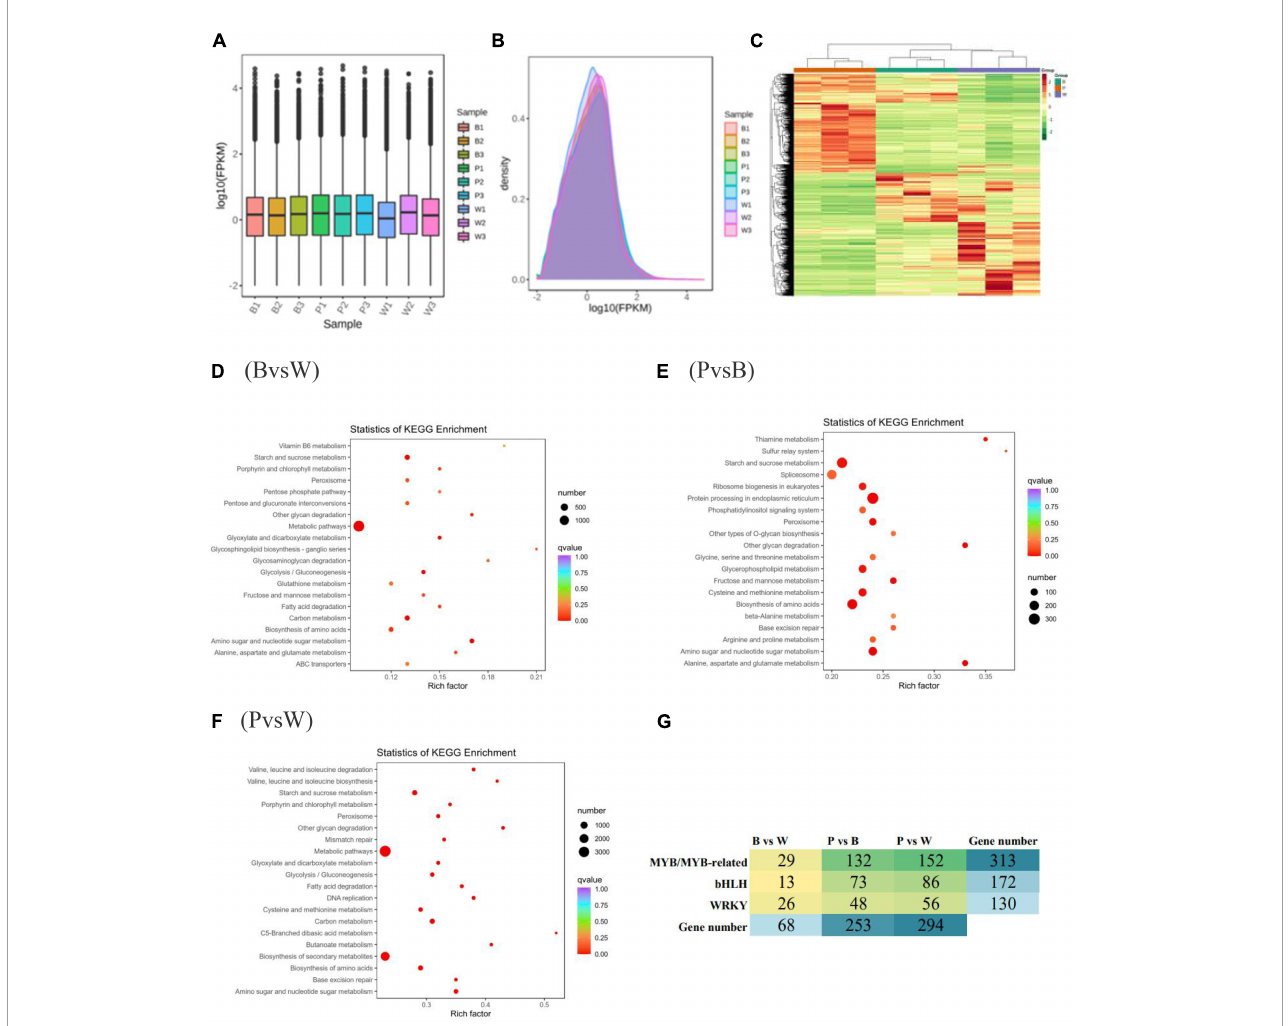
FIGURE4 (A) Box-and-whisker plot of gene expression level. (B) Gene expression density distribution map. (C) Heat map of differential gene clustering. The horizontal and vertical coordinates indicate the sample name and stratified clustering results for differential genes. (D–F) Scatter plot of differential gene KEGG enrichment. The horizontal and vertical coordinates represent the enrichment factor and KEGG pathway, respectively. The larger the enrichment factor, the redder it is, indicating the more enrichment quantity and high enrichment degree. (G) Heat map showing the number of different transcription factors (TF) families in different comparison